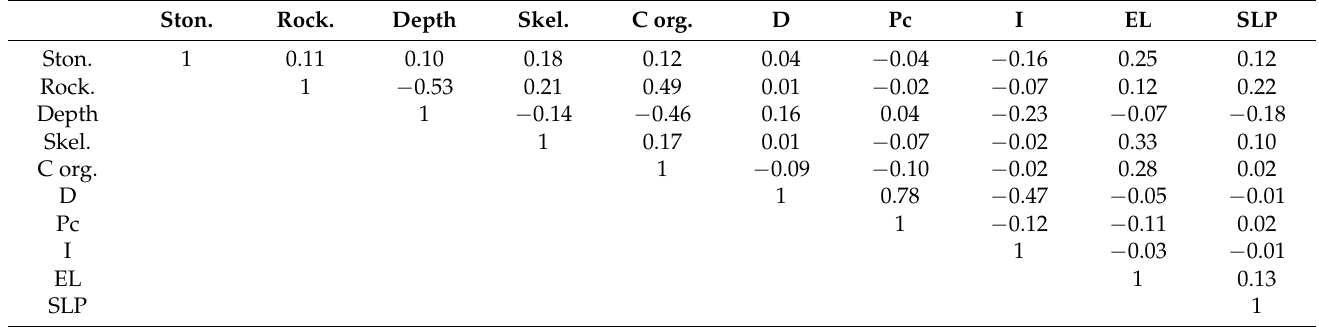
Table 4. Correlation matrix between soil and rainfall variables associated with landslides (N = 297); in bold; statistically significant values ( p < 0.05). Ston.: surface stoniness (%); Rock.: surface rockiness (%); Depth: soil depth (cm); Skel.: skeleton (%); C org.: soil organic carbon (%); D: rainfall duration (h); Pc: cu- mulative precipitation (mm); I: rainfall intensity (mm/h); EL: elevation from digital elevation model, mean value within a buffer of 40 m radius centered on landslide location (m a.s.l.); SLP: slope from digital elevation model, mean value within a buffer of 40 m radius centered on landslide location